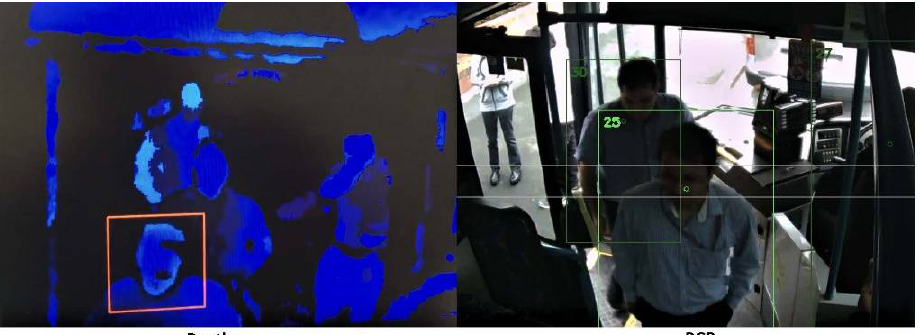
Figure 6. Passenger onboarding video.